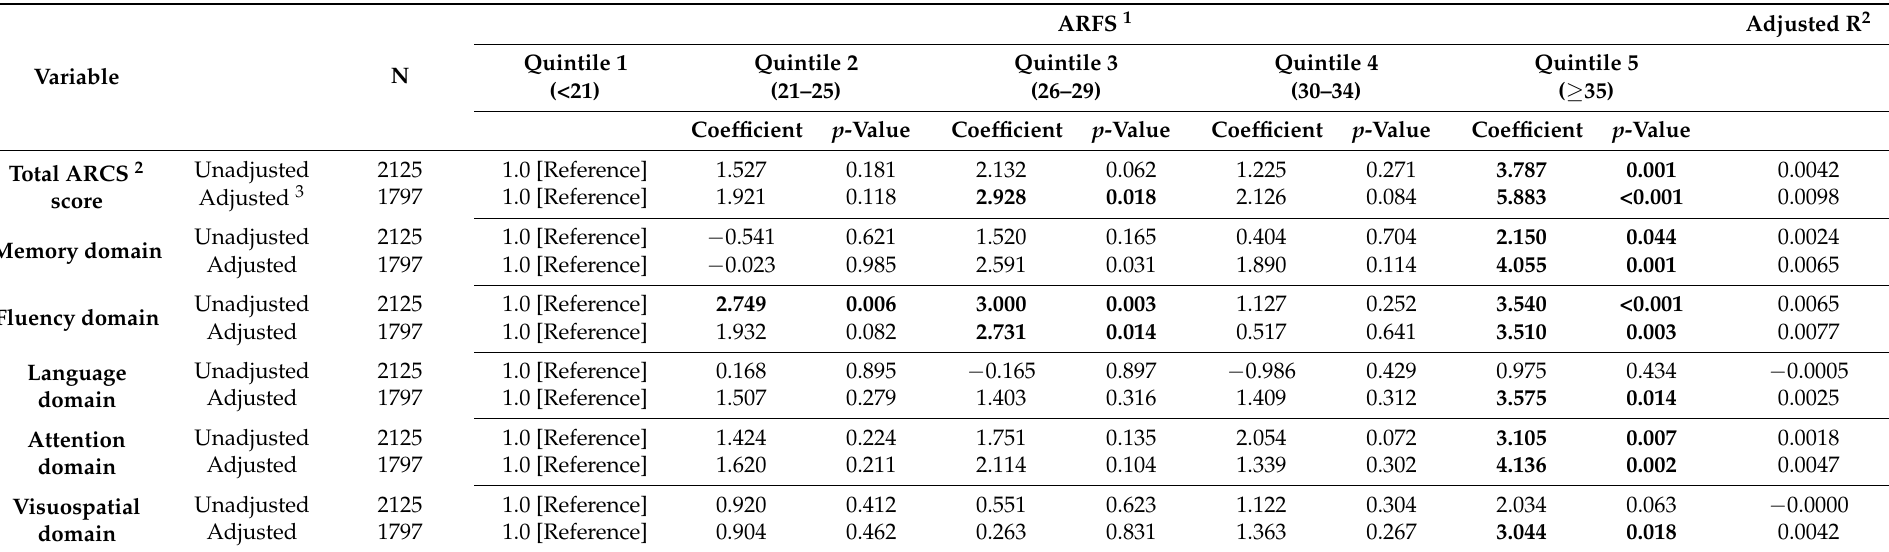
Table 3. Unadjusted and adjusted linear regression of total ARCS score (n = 2125) and ARCS subdomain scores by quintiles of ARFS score in the Hunter Community Study.